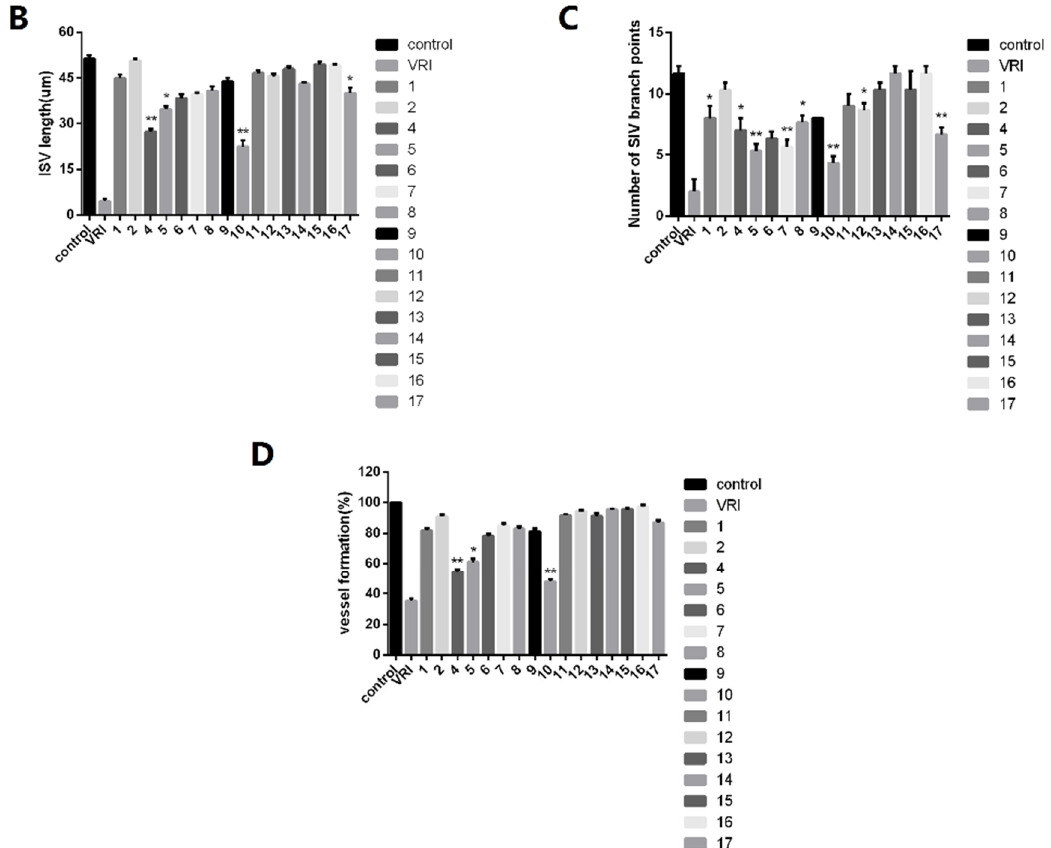
Figure 3. The anti-angiogenic activity of AA derivatives in zebrafish. Tg(fli1:eGFP) zebrafish embryos at 24 hpf were immersed in culture media containg 0.1% DMSO (control), 150 nM VRI (positive control) or 10 μ M compounds. ( A ) Live fluorescence microscopy highlights EGFP expressing intersegmental blood vessels (ISVs) and the subintestinal vessel plexus (SIVs), and the later which appears as a smooth basket-like structure with 5–6 arcades. Scale bar, 50 μ m. ( B , C ) Quantification of the ISV length and number of SIV branch points in 72 hpf zebrafish embryos in the vehicle control group and compounds treated groups. ( D ) Evaluation of the anti-angiogenic activity of the 16 compounds using EAP assay. * p < 0.05, ** p <